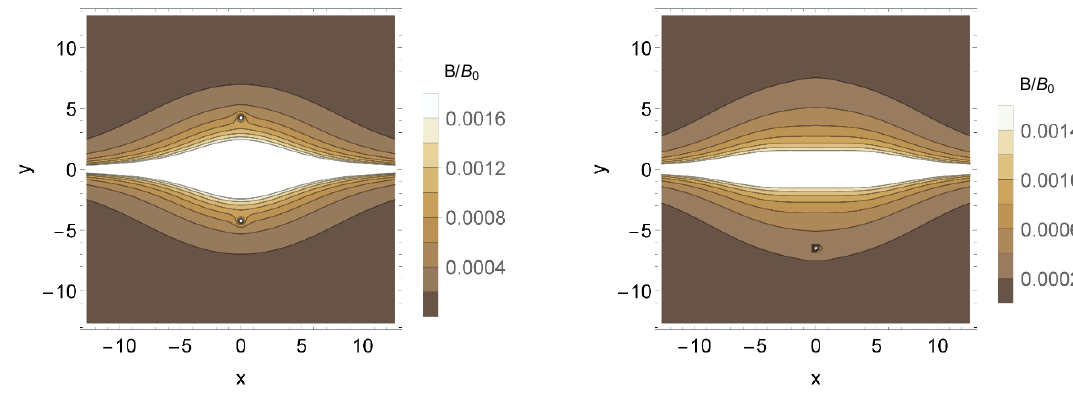
Figure 5 . (color online). The magnitude of the magnetic (cid:12)eld in the transverse plane from current free solution, i.e. eq. (4.1) using parameters (cid:12)xed in (6.7) for ! 1 = 0 : 5 ; ! 2 = 0 : 05 at (a) (cid:28) = 0 : 4 fm = c, and (b) (cid:28) = 5 fm = c. The height of the white areas is decreased with time.